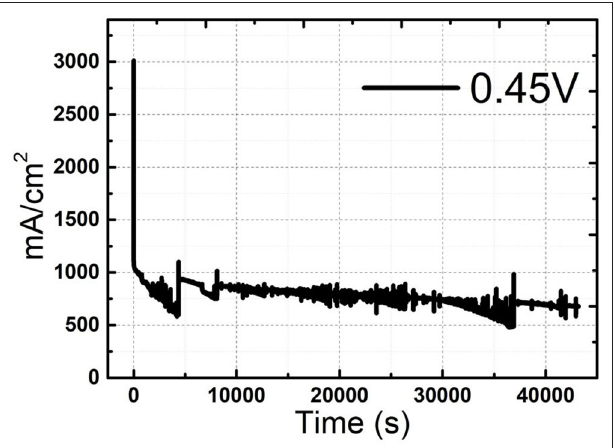
FIGURE 9 | Chronoamperometric curve of Ni-Pd(P)/MWCNT in 3.0M KOH/1.0M urea solution after CV at 0.45V for 40,000s.